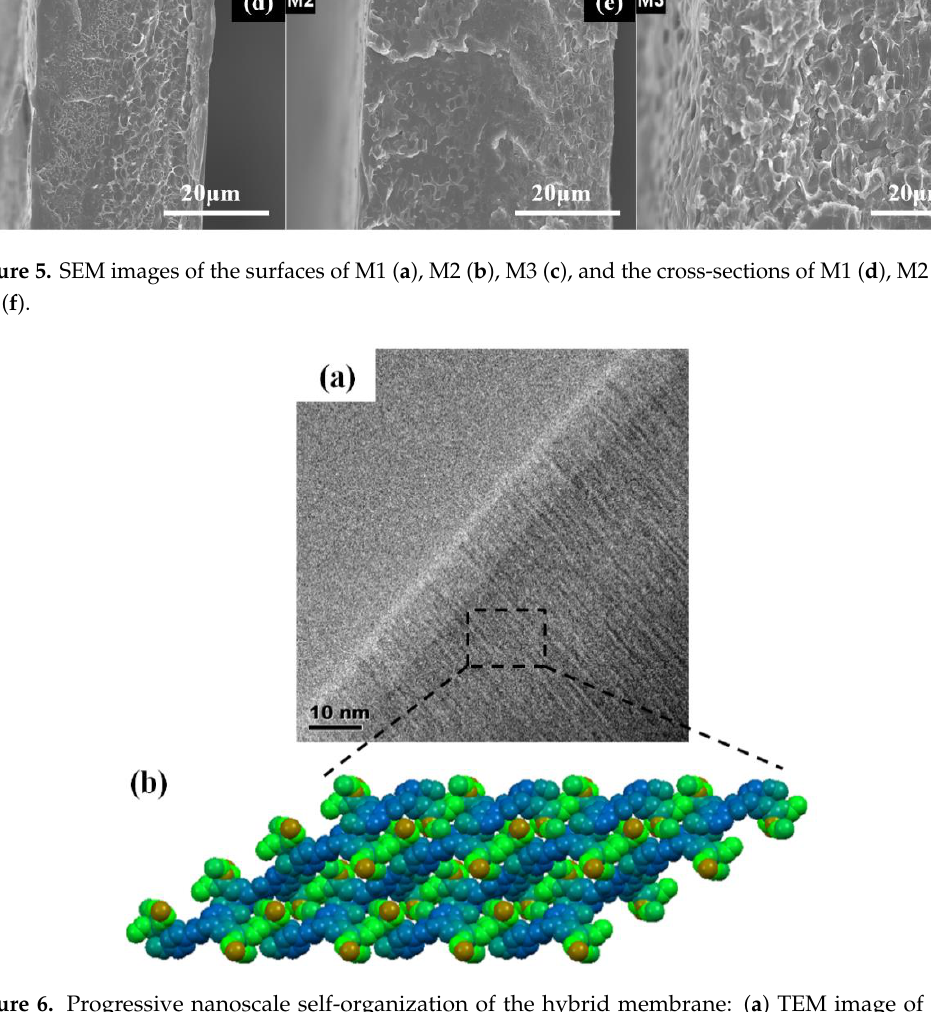
Figure 5. SEM images of the surfaces of M1 ( a ), M2 ( b ), M3 ( c ), and the cross-sections of M1 ( d ), M2 ( e ), M3 ( f ).